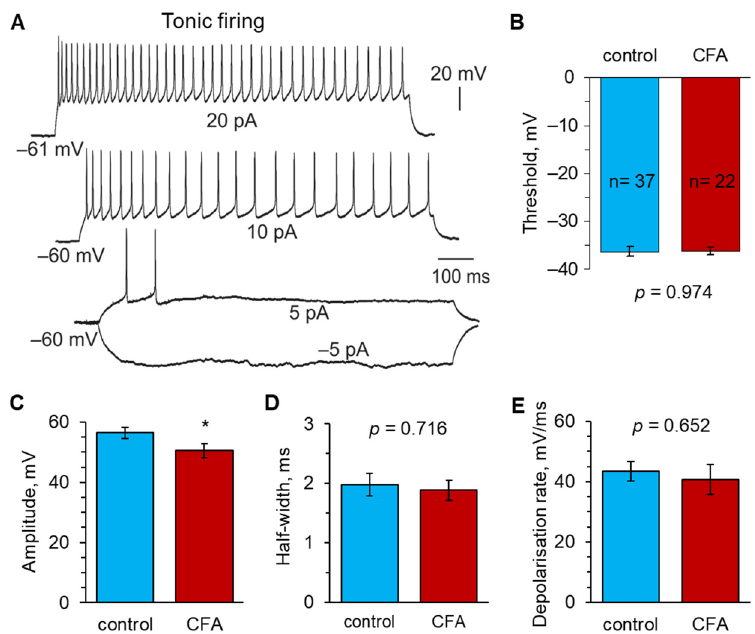
Figure 3. Peripheral inflammation does not increase the excitability of lamina I − II neurons exhibiting tonic firing. ( A ) An example of current-clamp recordings made from a superficial DH neuron with a tonic firing pattern of discharge in response to a stepwise increase in depolarising currents of the indicated intensity. ( B ) Statistical summary of the AP threshold in tonic firing neurons in control animals and those with peripheral inflammation at 1 d post-CFA. ( C ) Peripheral inflammation decreases the spike amplitude in tonic firing lamina I − II neurons. ( D , E ) Statistical summary of the kinetics of APs generated by tonic firing DH neurons for the half-width ( D ) and the depolarisation rate ( E ) in the control and CFA ‐ inflamed groups. All data are means with SEM; the number of recorded cells is indicated. * p < 0.05 (unpaired two ‐ tailed t ‐ test).